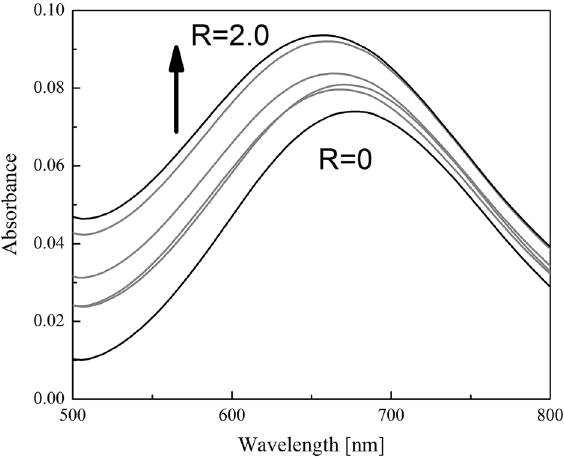
Figure 6. UV–vis spectra of CuST (0.9 mM) in d–d region, under various concentrations of lysozyme (0−1.8 mM) in 0.1 M phosphate buffer (pH 7.0). R: Concentration ratio of lysozyme vs. CuST (C lysozyme /C CuST ). These spectra were measured at every 0.4 steps of R (R = 0, 0.4, 0.8, 1.2, 1.6, 2.0).